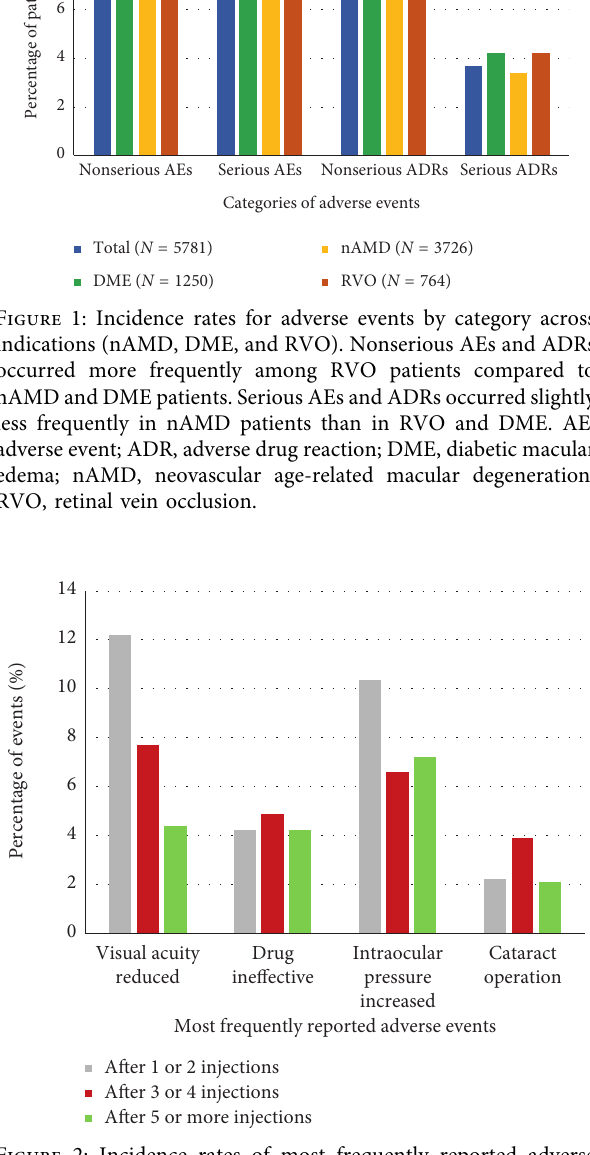
Figure 2: Incidence rates of most frequently reported adverse events stratified by how many injections of ranibizumab the patient received before adverse event (AE) occurred. None of the most frequently reported adverse events occurred more frequently with higher number of injections. Percentages are based on the total number of AEs (2687 AEs � 100%). Figure shows all events oc- curring with a rate of ≥ 2%